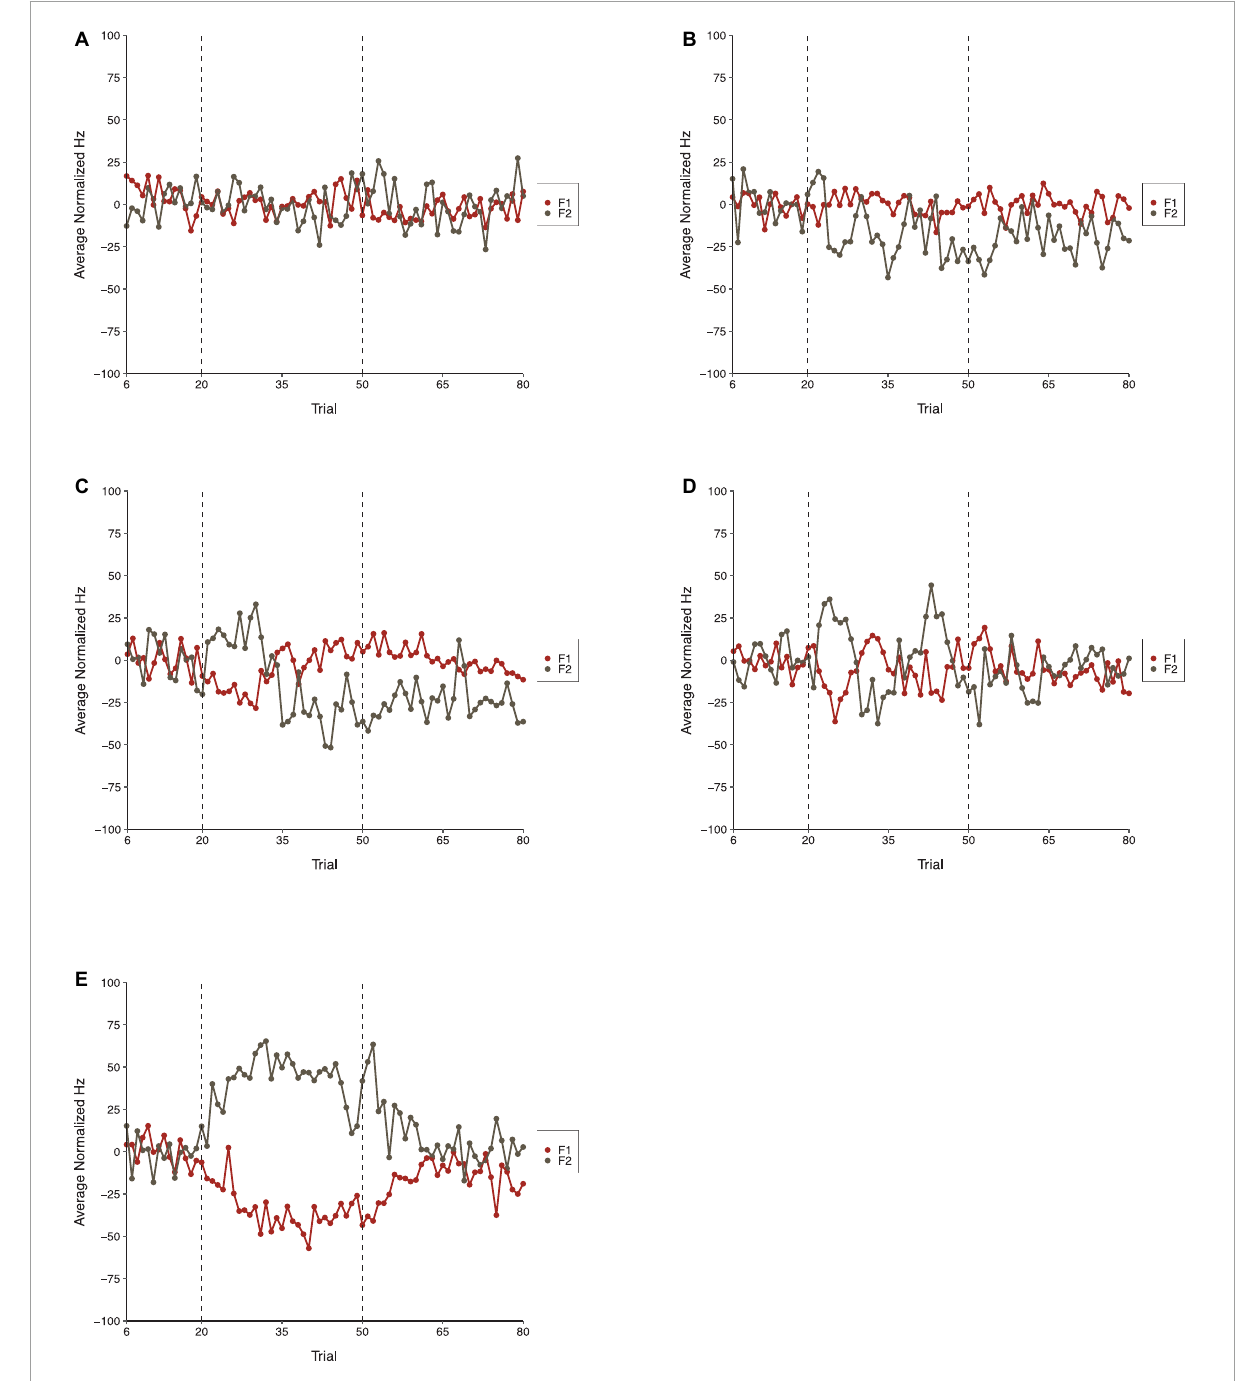
FIGURE7 Average normalized F1 (red) and F2 (gray) speech production values in the Control Condition (A) , Condition One (B) , Condition Three (C) , Condition Six (D) , and the Step Condition (E) of Experiment 2. From left to right, dotted lines denote boundaries between the Baseline, Perturbation, and Return phases,